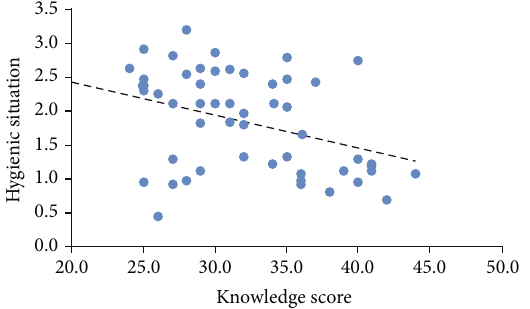
Figure 3: The correlation between knowledge and hygiene practice at selected restaurants in Muscat